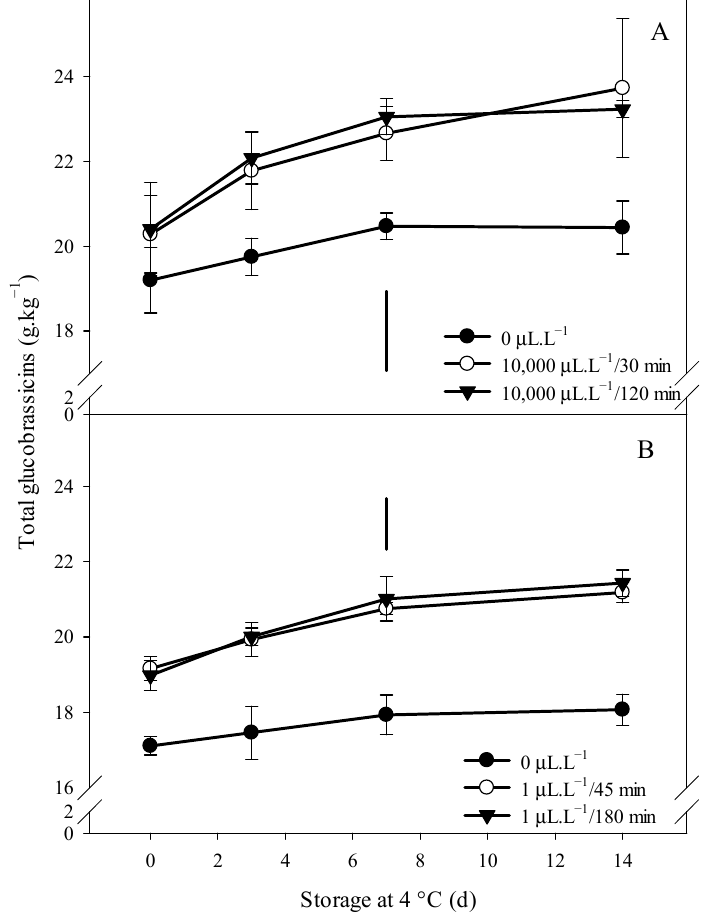
Figure 5. Total glucobrassicin content of florets exposed to ethanol and methyl jasmonate. Broccoli florets were treated with ethanol ( A ) at three di ff erent doses: ( ● ), control; ( ○ ), 10,000 µL.L − 1 /30 min (hormetic dose); and ( ▼ ), 10,000 µL.L − 1 /120 min (high dose). Methyl jasmonate ( B ) ( ● ), control; ( ○ ), 1 µL.L − 1 /45 min (hormetic dose); and ( ▼ ), 1 µL.L − 1 /180 min (high dose). Color change ( Δ E) was observed during 21 d of storage in darkness at 4 °C. The content of total glucobrassicins (glucobras- sicin + neoglucobrassicin + 4-hydroxyglucobrassicin + 4-methoxyglucobrassicin) was monitored for 14 days of storage in darkness at 4 °C. Vertical bars represent the standard deviation (n = 4). LSD (0.05), EtOH = 1.88; LSD (0.05), MeJA = 1.36. Table 1. Glucosinolate content of ethanol and methyl jasmonate-treated broccoli. Florets were exposed to three different doses of ethanol (control: 0 µ L.L − 1 ; hormetic: 10,000 µ L.L − 1 /30 min; high: 10,000 µ L.L − 1 /120 min) and methyl jasmonate (control: 0 µ L.L − 1 ; hormetic: 1 µ L.L − 1 /45 min; high: 1 µ L.L − 1 /180 min), stored for 14 days in darkness at 4 ◦ C, and the obtained values were time averaged (0, 7, and 14